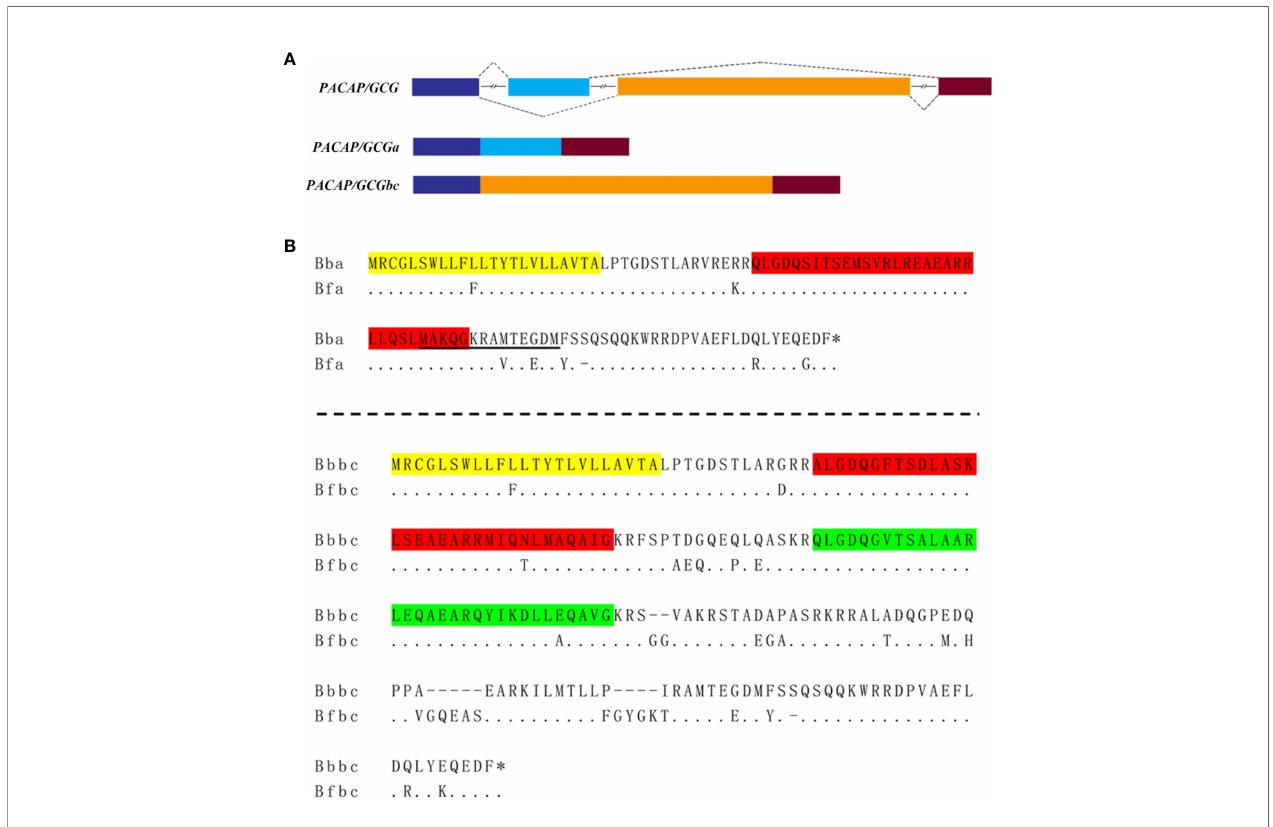
FIGURE 1 | The amphioxi PACAP/GCG gene and transcripts. (A) Schematic representation of the B . fl oridae gene and the two alternative spliced transcript variants PACAP/GCGa and PACAP/GCGbc . The predicted exons are representedby different colored boxes, andthe line indicates the introns. (B) Multiplesequence alignment of the deduced aminosequences of the two transcript precursor variants between B. belcheri (Bb) and B. fl oridae (Bf). The predictedsignal peptide sequence ishighlighted in yellow and the deducedmature peptides in each transcript precursor arein red (PACAP/CGCa and PACAP/GCGb) andgreen (PACAP/GCGc).The amino acid sequence underlinedwas usedas antigen to produce the PACAP/GCGa antibody. The asterisk “ * ” represents the STOP codon.Bfa, B. fl oridae PACAP/GCGa ; Bfbc, B. fl oridae PACAP/GCGbc ; Bba, B. belcheri PACAP/GCGa ; Bbbc, B.belcheri PACAP/GCGbc